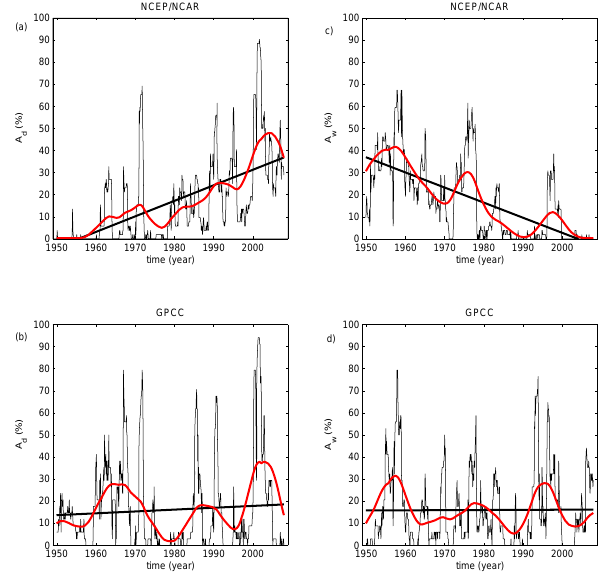
Fig. 2. Time behaviour of A d and A w from December 1949 to December 2007 for the SPI on 24-month time scale computed using NCEP/NCAR and GPCC data: a)–b) dryness, and c)–d) wetness. Straight black lines denote the fitting linear trends, while red lines are the reconstructions of A d and A w using only the leading SSA principal component. Units are